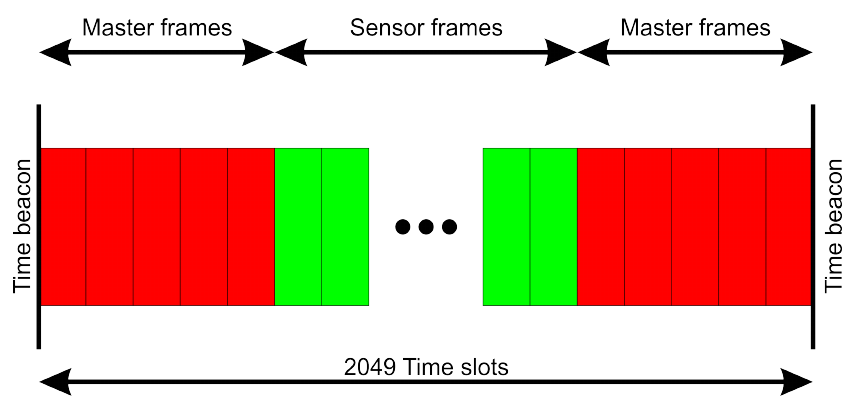
Figure 4. TDMA scheme of the IPANEMA generation 2.5